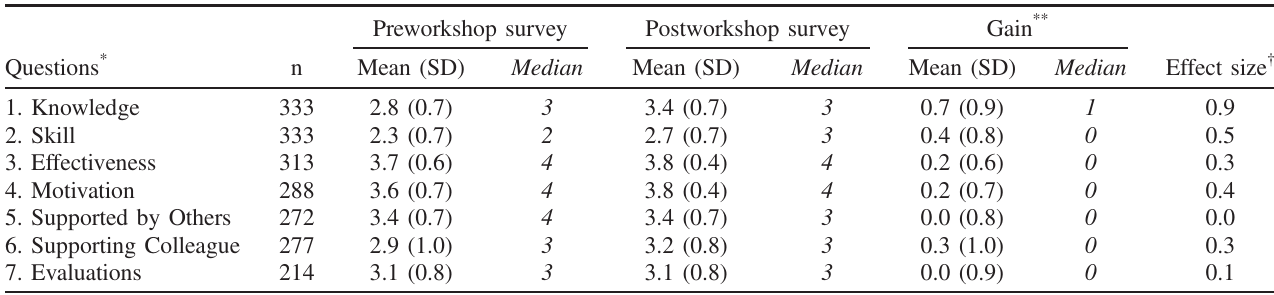
TABLE III. Mean, median, and gain scores for attitude and belief